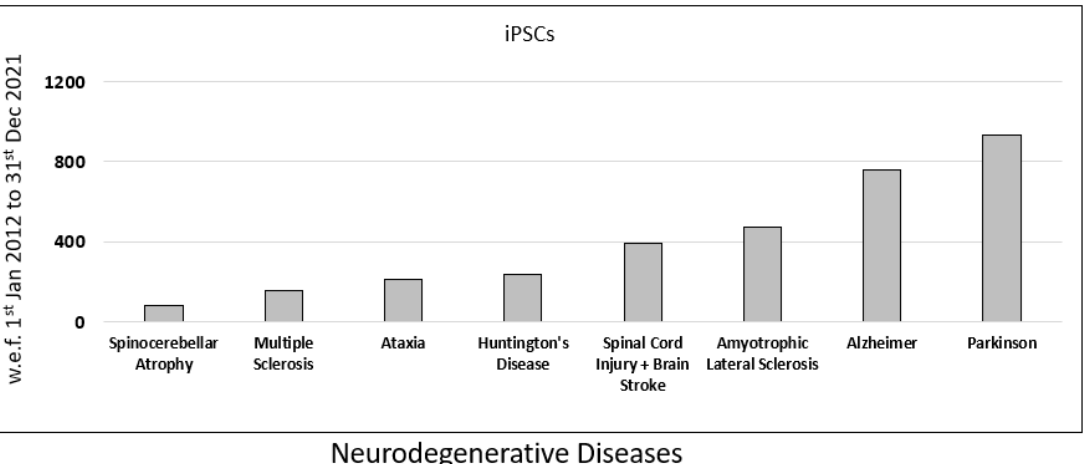
Figure 3. Published data for iPSCs research in the last decade. Comparison of different neurodegen- erative diseases such as spinocerebellar atrophy, multiple sclerosis, ataxia, spinal cord injury (SPI), Huntington ’ s disease, amyotrophic lateral sclerosis (ALS), Alzheimer's disease (AD), and Parkin- son's disease (PD), based on scientific research published in PUBMED in the last decade (w.e.f. 1 January 2012 to 31 December 2021).